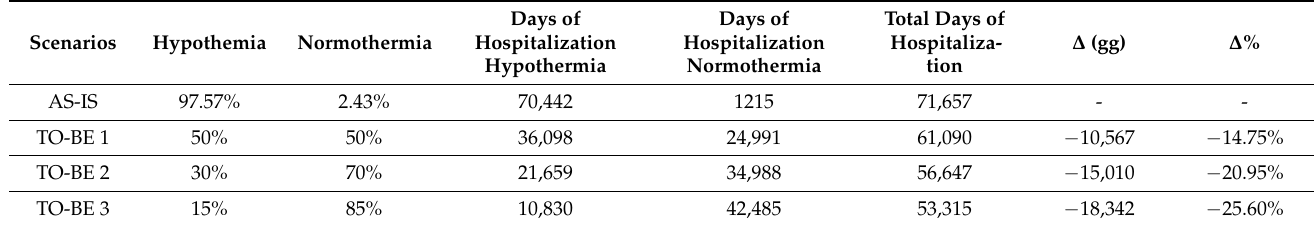
Table 6. Impact on reduction in hospitalization